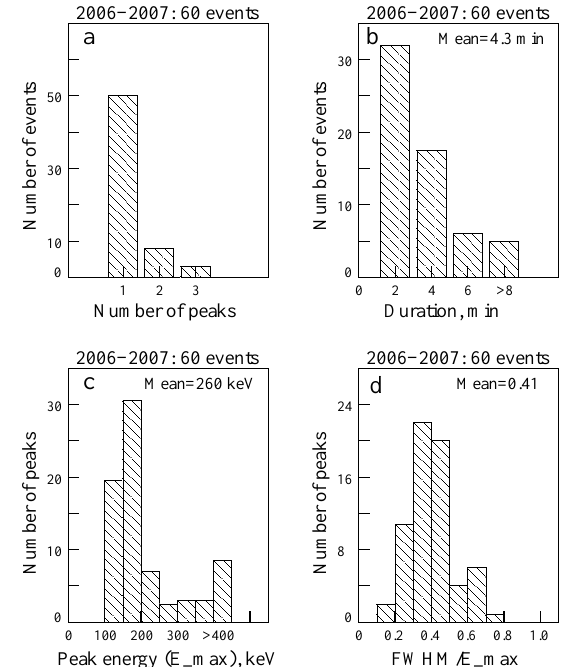
Fig. 7. Distributions of AMI characterictics. (a) Number of peaks in spectra. In the majority of events (50 of 60) only one peak is detected. (b) Duration of AMI events. The mean duration is 4.3 minutes. Only events with duration ≥ 2 minutes are included in the statistics. (c) Distribution of peak energy and (d) the relative width (FWHM / E max ) for all events detected in the range 100-1200 keV. The majority of peaks occur at energies ≤ 200 keV with relative FWHM ≤ 0.4. The mean values of the distributions are given in the plots.